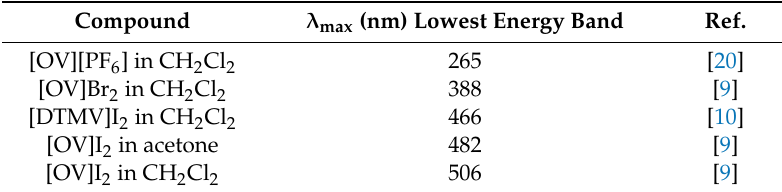
Table 1. Experimental maximum absorption wavelength, λ max in nm, of the lowest-energy band for the compounds in solution. Concentration was in the range 2–5 × 10 − 2 M. Compound λ max (nm) Lowest Energy Band Ref. [OV][PF 6 ] in CH 2 Cl 2 265 [20] [OV]Br 2 in CH 2 Cl 2 388 [9] [DTMV]I 2 in CH 2 Cl 2 466 [10] [OV]I 2 in acetone 482 [9] [OV]I 2 in CH 2 Cl 2 506 [9] OV = octylviologen, 1,1 (cid:48) -dioctyl-4,4 (cid:48) -bipyridinium; DTMV = decyltetramethylviologen, 1,1 (cid:48) -didecyl-2,2 (cid:48) ,6,6 (cid:48) - tetramethyl-1,1 (cid:48)